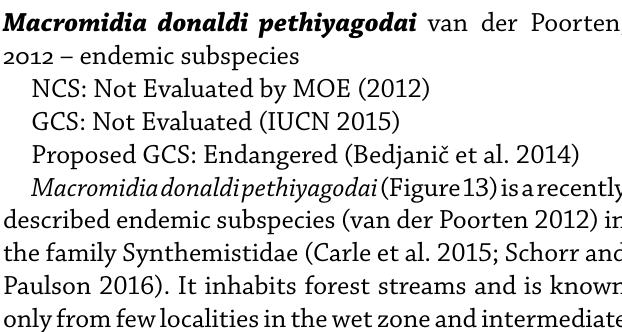
Figure 14. Distribution of Macromidia donaldi pethiyagodai with new